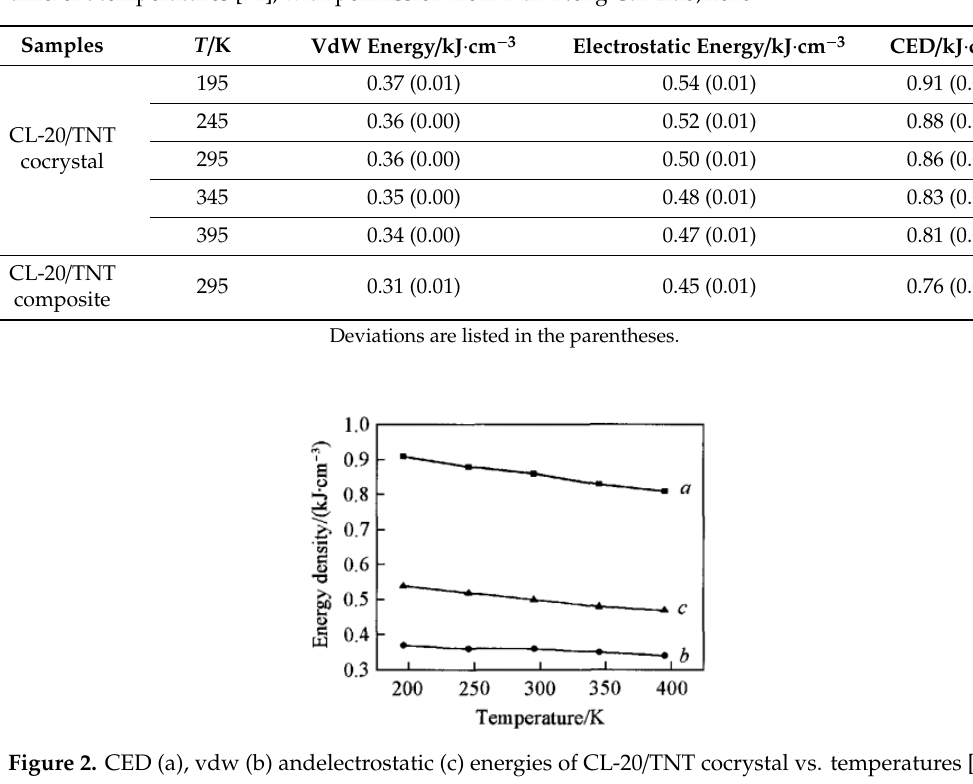
Table 2. The cohesive energy density (CED) of CL-20 / TNT cocrystal and its CL-20 / TNT composite at